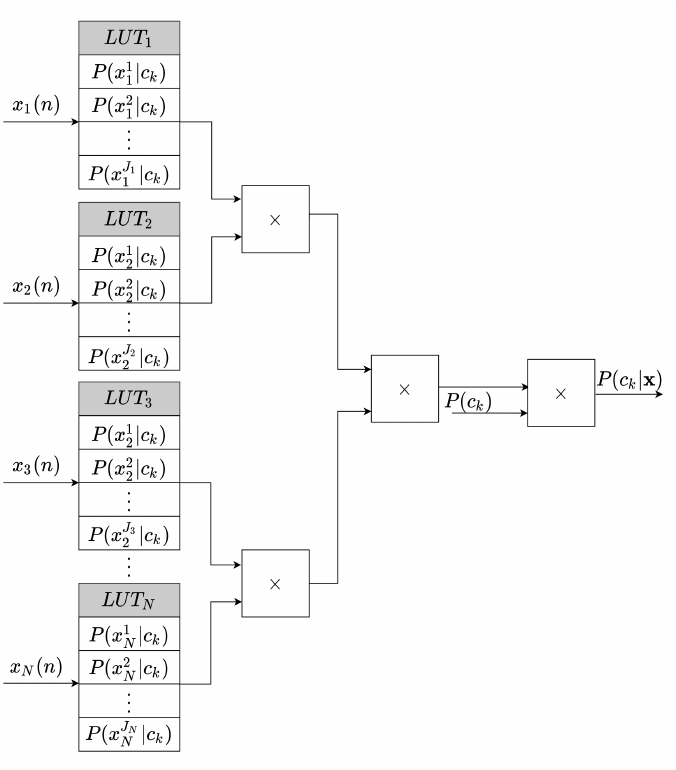
Figure 7. Internal architecture of a k -th P ( c k | x )